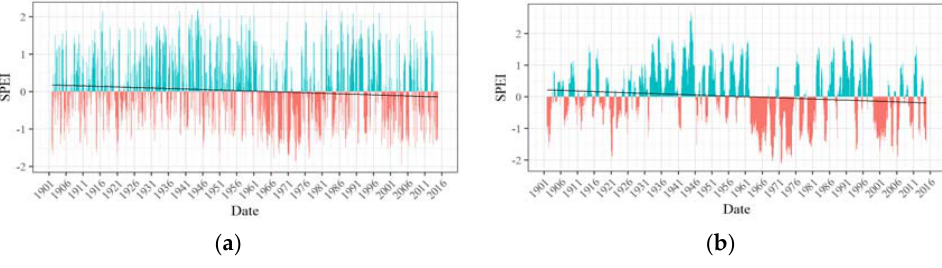
Figure 6. ( a ) 3 ‐ month and ( b ) 12 ‐ month SPEI time series of Zone 2.